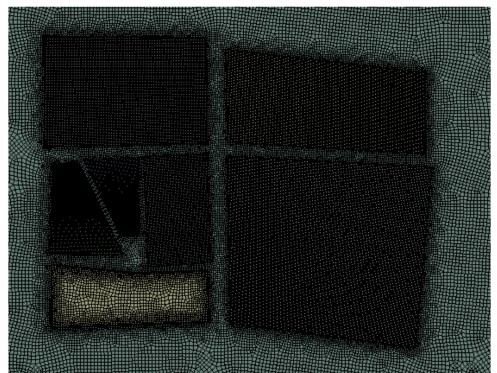
Figure 6. Mesh for modeling porous